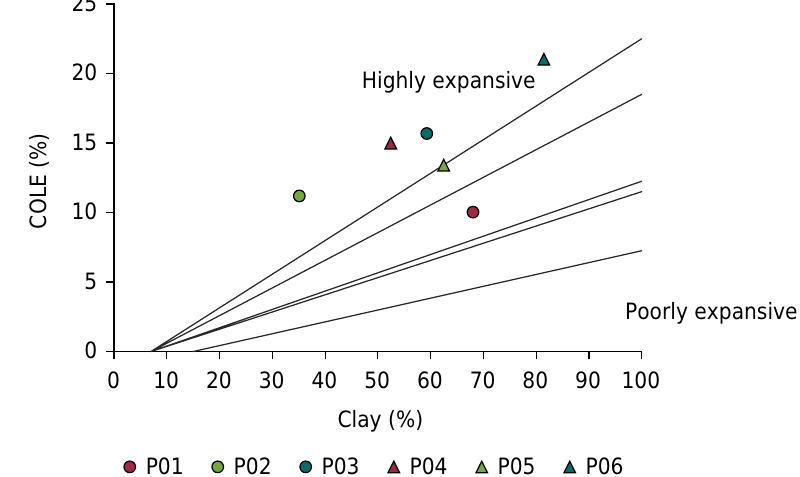
Figure 5. Classification of clay expansion potential (Lucian, 2016). COLE: coefficient of linear expansion [COLE (%) = COLE ×